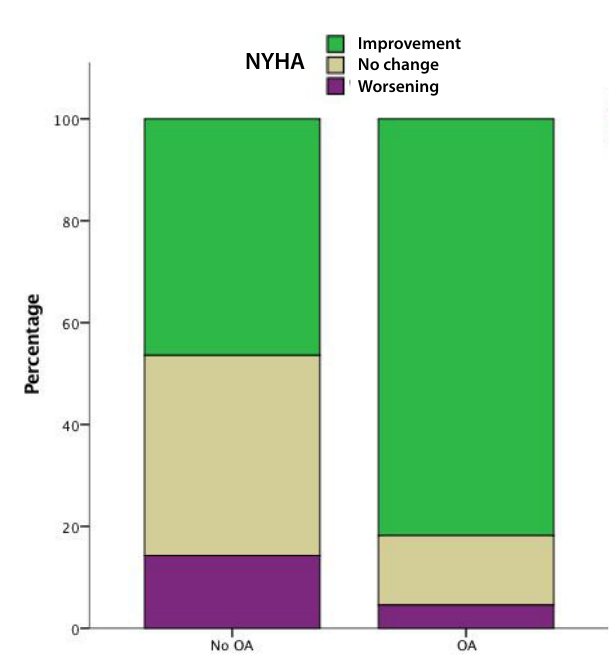
Fig. 2 – Change in New York Heart Association (NYHA) class at follow-up in patients with and without oral anticoagulation (OA) with ≤ 21 mm prosthesis. Green=patients who improved their NYHA; brown=patients who reported no change in their NYHA; purple=patients who reported worsening of their NYHA